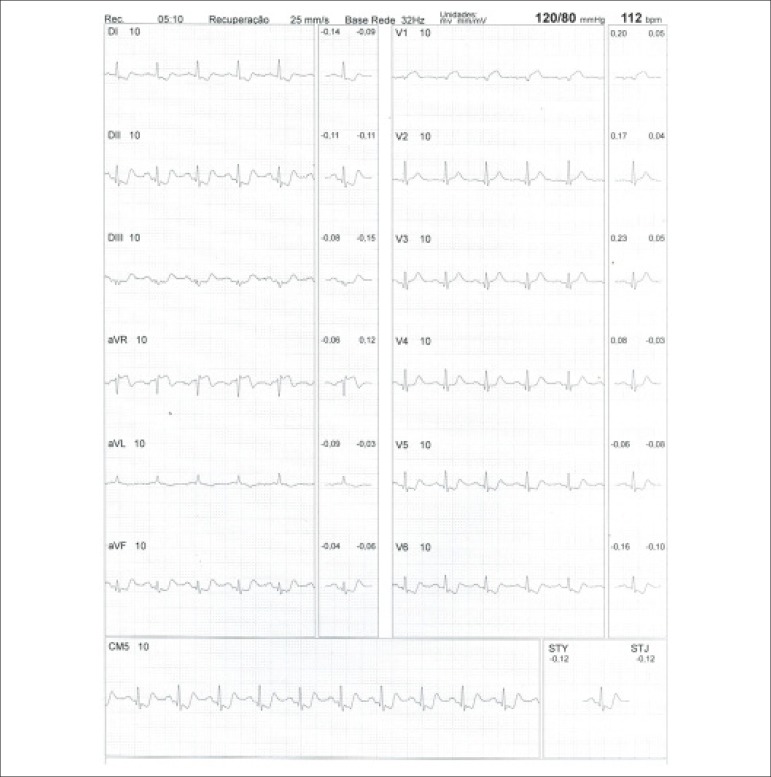
Case 12 - Electrocardiogram showing prolonged ischemic alterations during the late recovery phase.